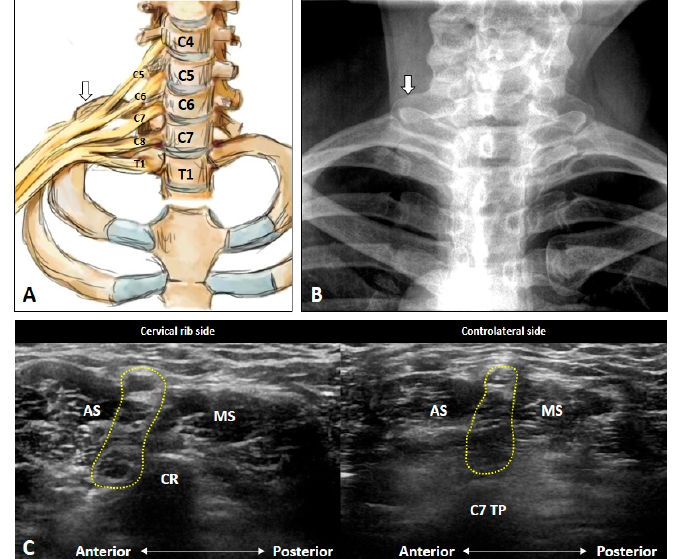
colli muscle; MS: middle scalene muscle; PT: posterior tubercle; TP: transverse process; VA: vertebral artery. The yellow dashed area encircles the brachial plexus and the blue rectangle represents the transducer position.